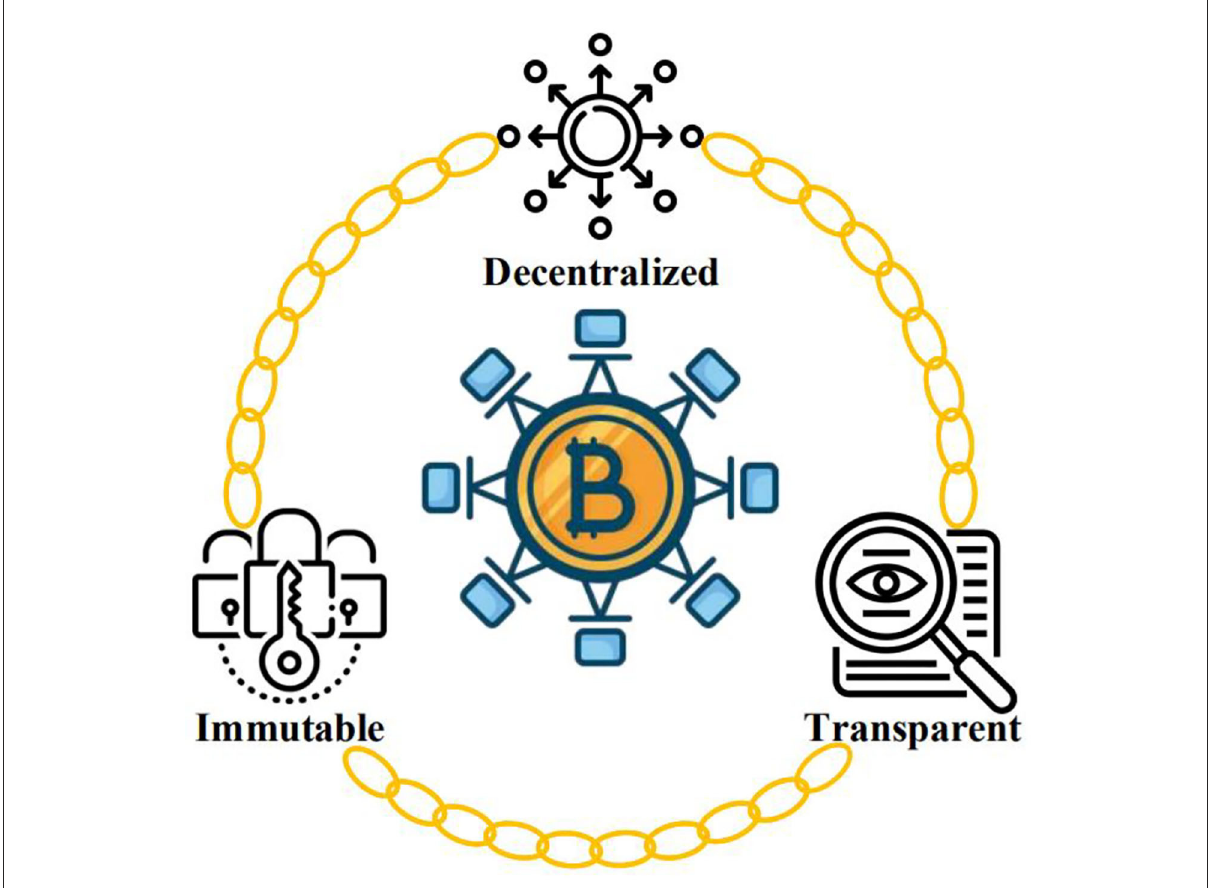
FIGURE5 Characteristics of a blockchain